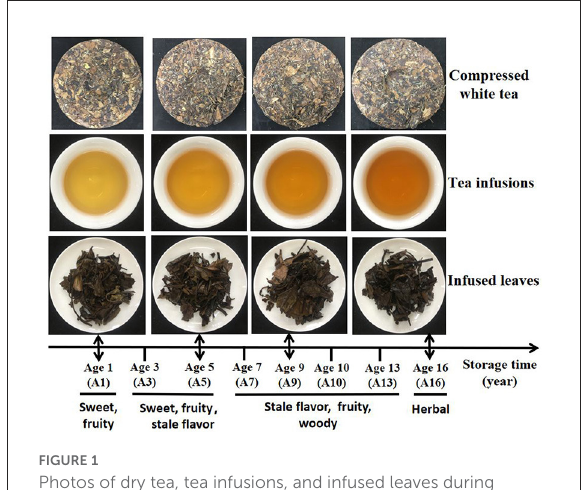
FIGURE1 Photos of dry tea, tea infusions, and infused leaves during long-term storage of CWT.